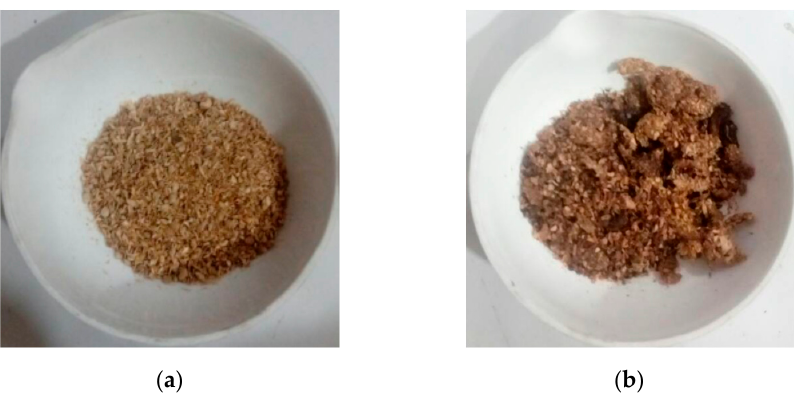
Figure 5. Fragments of biomass particles in melting PP with feed containing 0% weight of PP ( a ), combined flocks and fragments of biomass particles in melting PP from a sample taken when co-pyrolysis with feed containing 25% weight of PP ( b ). Samples were taken when co-pyrolysis achieved 300°C.